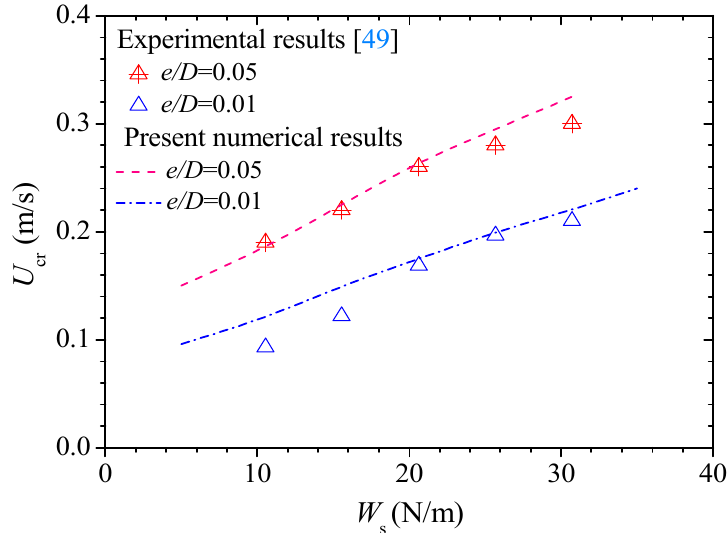
Figure 5. Variations of the critical velocity for the lateral instability ( U cr ) with the submerged weight of the pipe ( W s ) for e/D = 0.01 and 0.05 ( D = 0.14 m).